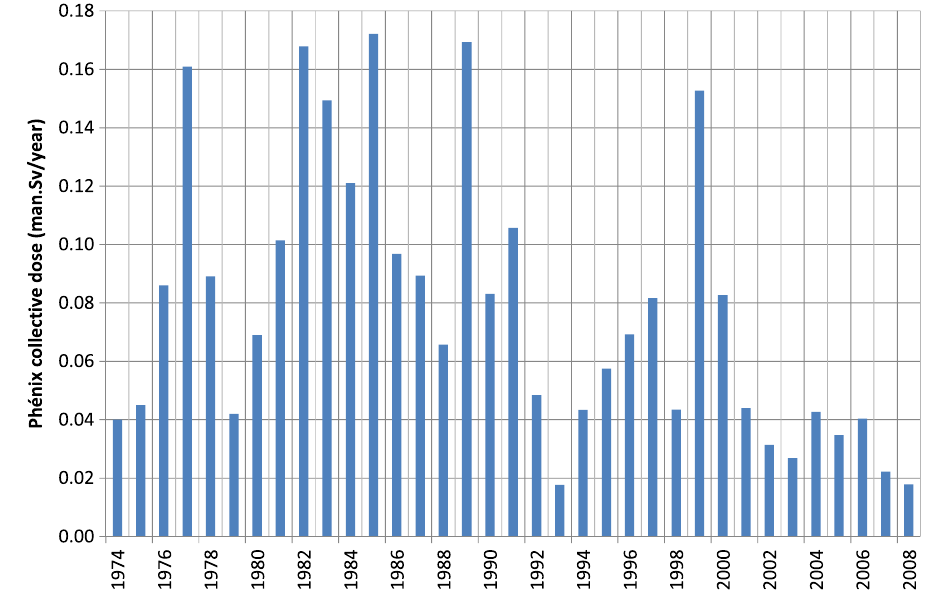
Fig. 10. Annual collective doses during Phénix operational period